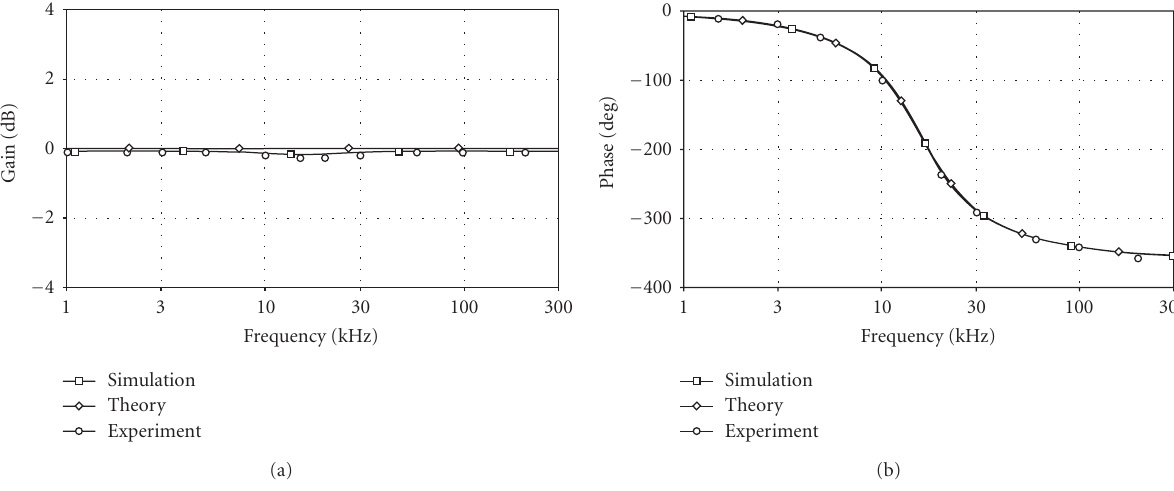
Figure 7: Frequency responses of the AP filter, (a) gain response and (b) phase